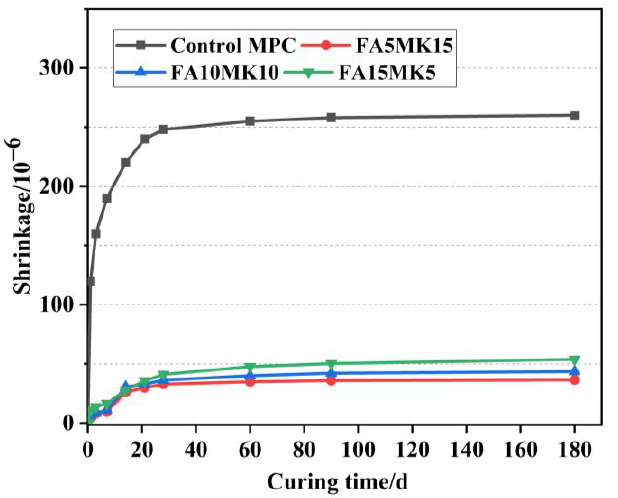
Figure 20. Drying shrinkage of MPC pastes with addition of compound powder.